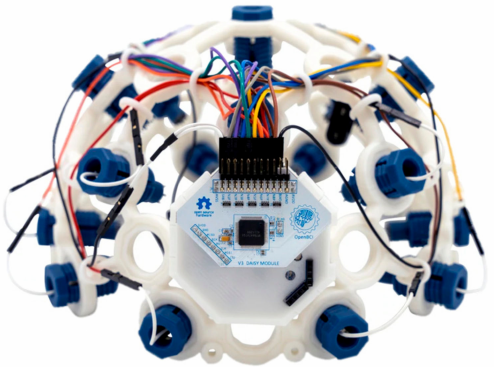
Figure 3. ( a ) 10–20 system for EEG monitoring on the scalp; ( b ) 16-electrode positioning by the Open BCI headset.